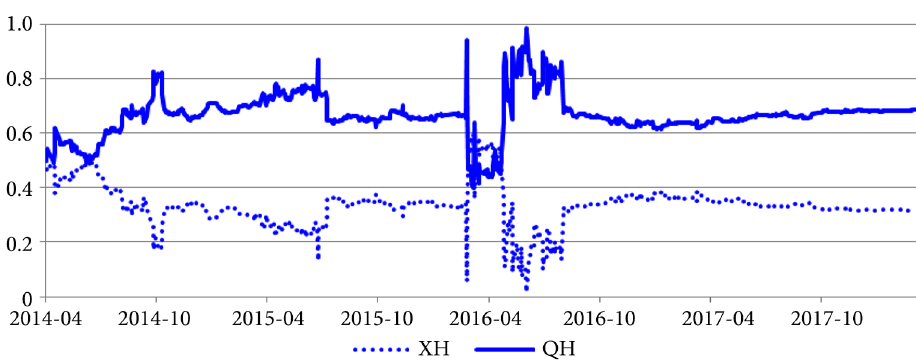
Figure 4. Contribution of price discovery in iron ore futures market (QH) and spot market (XH) (time: